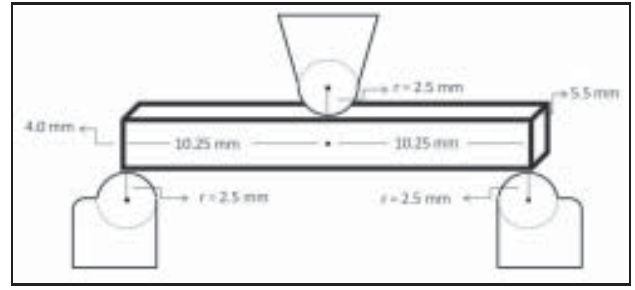
Figure 2 – Flexural strength test schematic‘s representation.